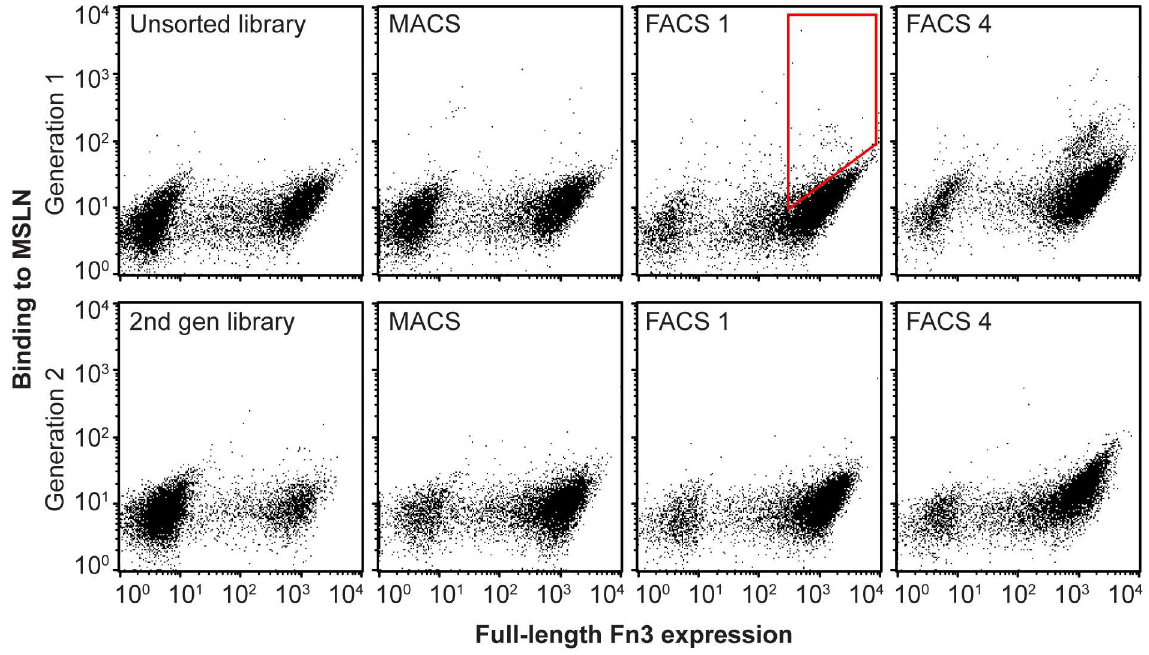
Fig 2. Directed evolution of a na ï ve yeast surface display library yielded Fn3 variants that bind soluble MSLN. We started with a na ï ve yeast surface display library with 2.8 x 10 9 variants of the Fn3 non-antibody scaffold. The library was sorted for full-length protein expression, detected by an antibody to a terminal c-myc epitope tag, and binding to MSLN using MACS and FACS. Red polygon indicates example cell population collected for further enrichment and analysis. Additional diversity was introduced into the enriched library through a single round of mutagenic PCR and sorting of this second generation library resulted in further enrichment for MSLN binding variants. A double-negative population of yeast cells is characteristic of yeast surface display.